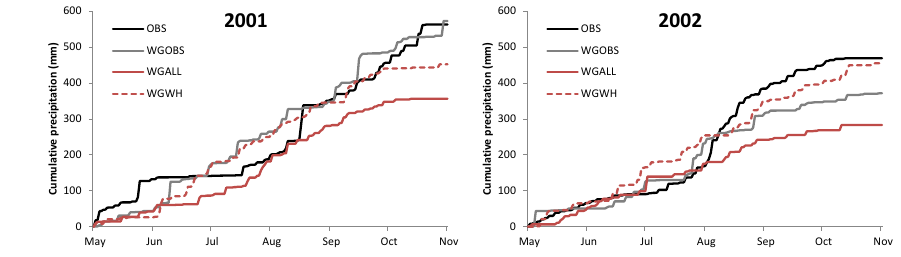
Fig. 19. Observed and generated cumulative precipitation totals for the growing seasons of 2001 and 2002 at Taiz.